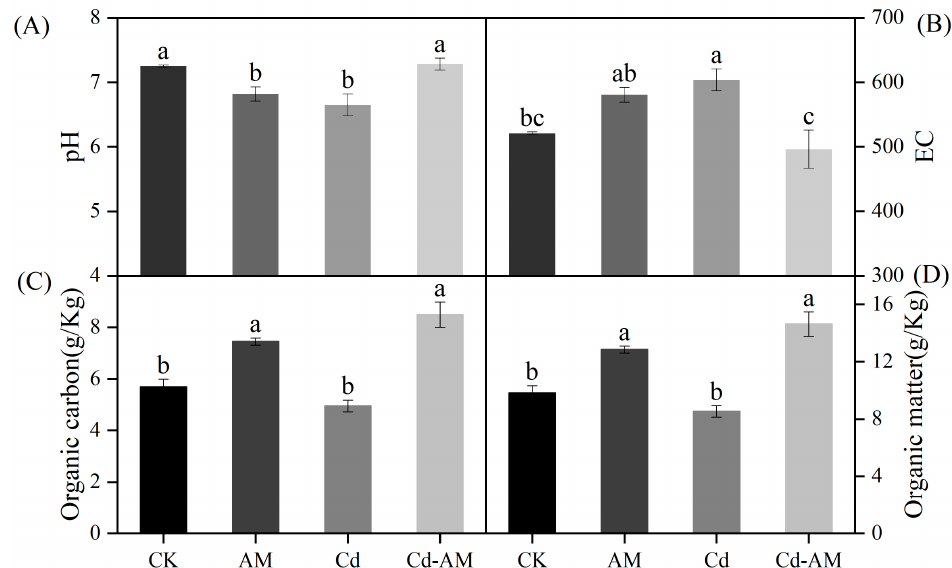
Figure 4. Inter-root soil physicochemical properties under different treatments. Soil potential of hydrogen (pH) ( A ), electrical conductivity (EC) ( B ), organic carbon ( C ), and organic matter content ( D ). Values are expressed as means ± SE ( n = 3). Values followed by the same letter in the same column are not significantly different ( p < 0.05).